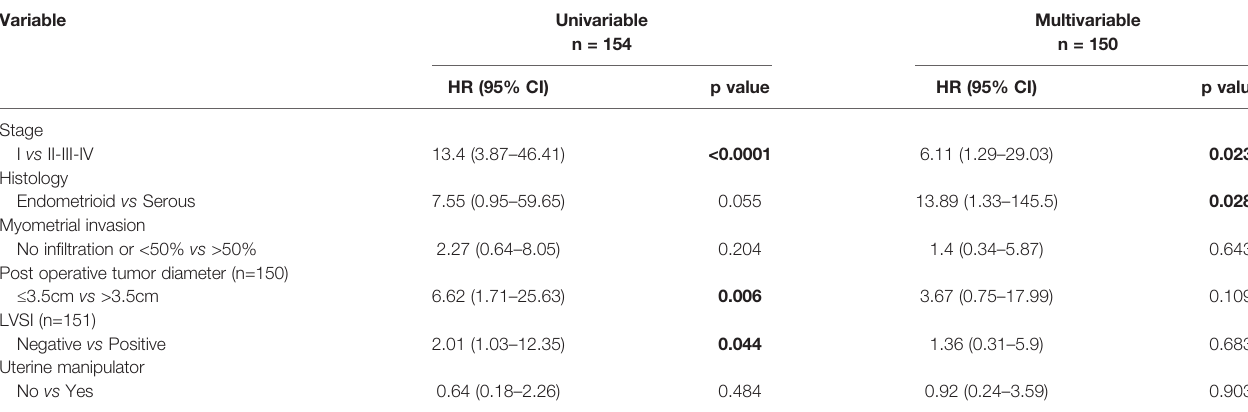
TABLE 5 | Univariable and multivariable analysis of